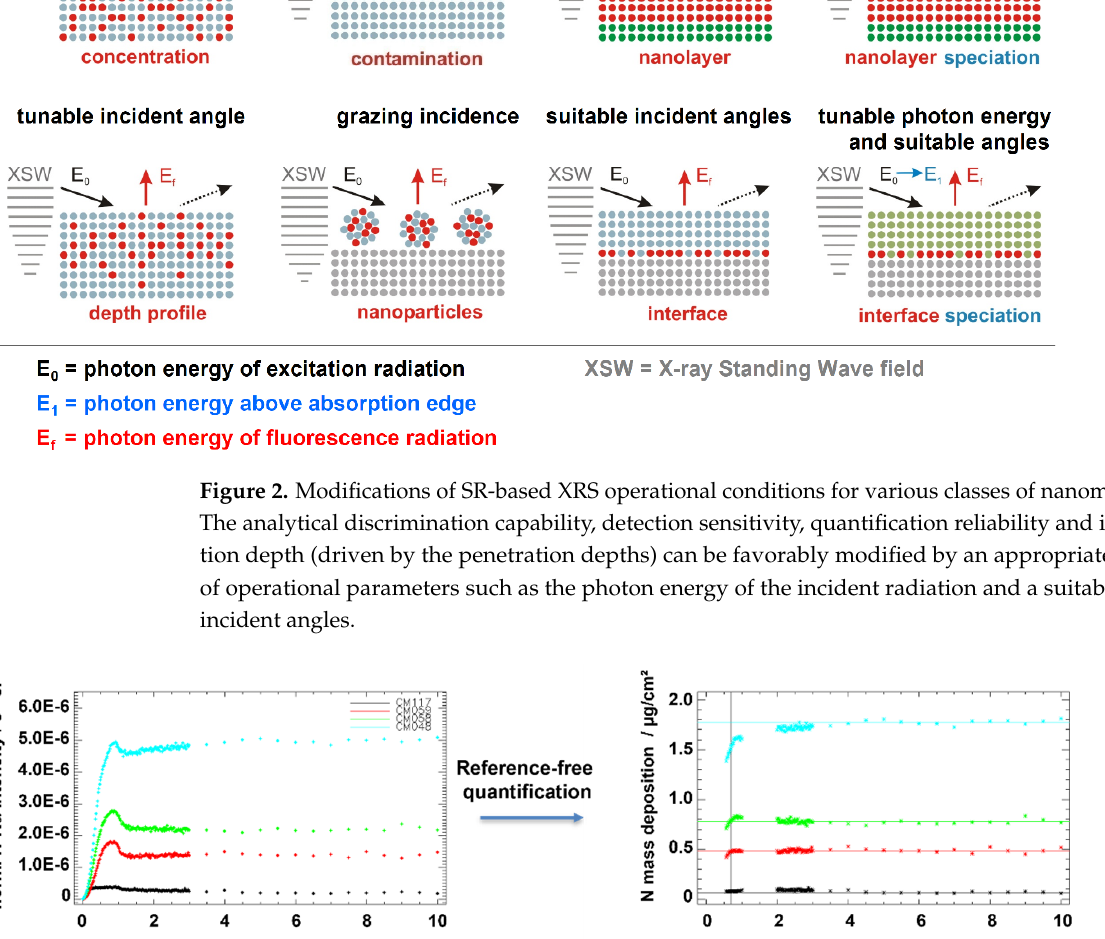
Figure 2. Modifications of SR-based XRS operational conditions for various classes of nanomaterials. The analytical discrimination capability, detection sensitivity, quantification reliability and infor- mation depth (driven by the penetration depths) can be favorably modified by an appropriate choice of operational parameters such as the photon energy of the incident radiation and a suitable set of incident angles.